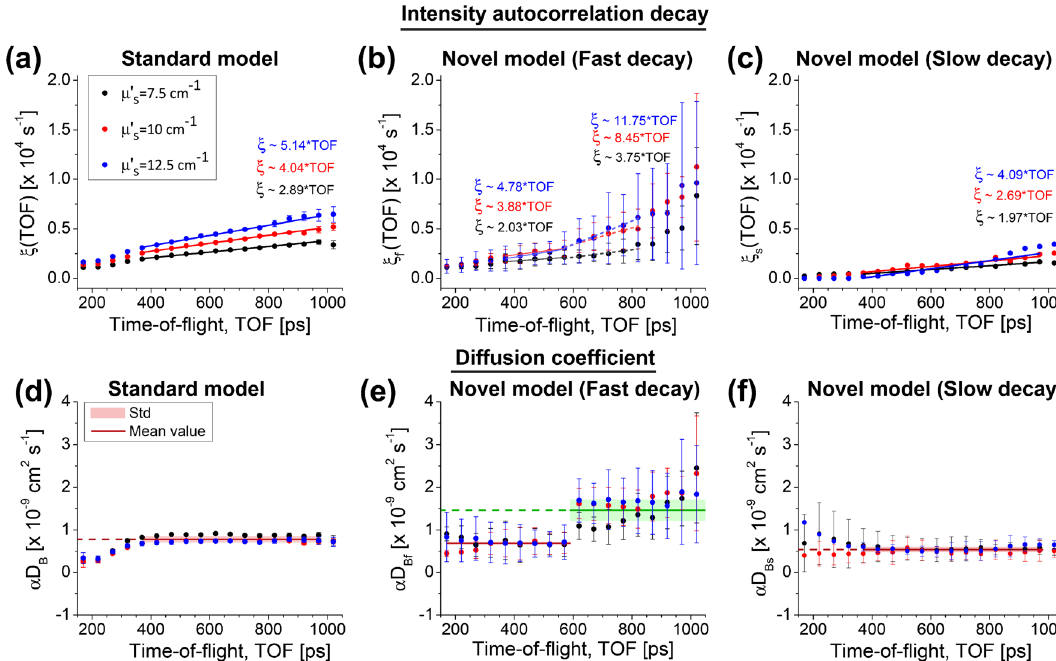
Figure 3. Time-domain diffuse correlation spectroscopy measurement in two-layer liquid phantoms with absorption coefficient ( µ a = 0.06cm − 1 ) and variable reduced scattering ( µ ′ s = 7.5, 10.0, and 12.5cm − 1 ). ( a – c ) Estimated TOF-resolved autocorrelation decays and the diffusion coefficients ( d – f ). The standard model provides a constant slope of the ACF decays, and thus is incapable to distinguish flows in different layers ( d ). On contrary, the fast component of the novel model changes at 600 ps ( b ), which allows to clearly separate the depth-dependent diffusion coefficients ( e ). The slow component of the novel model senses the top layer along different TOFs by providing a uniform slope of ACF decay ( c ), and a constant diffusion coefficient ( f ) close to the value estimated by the fast component at early TOFs ( e